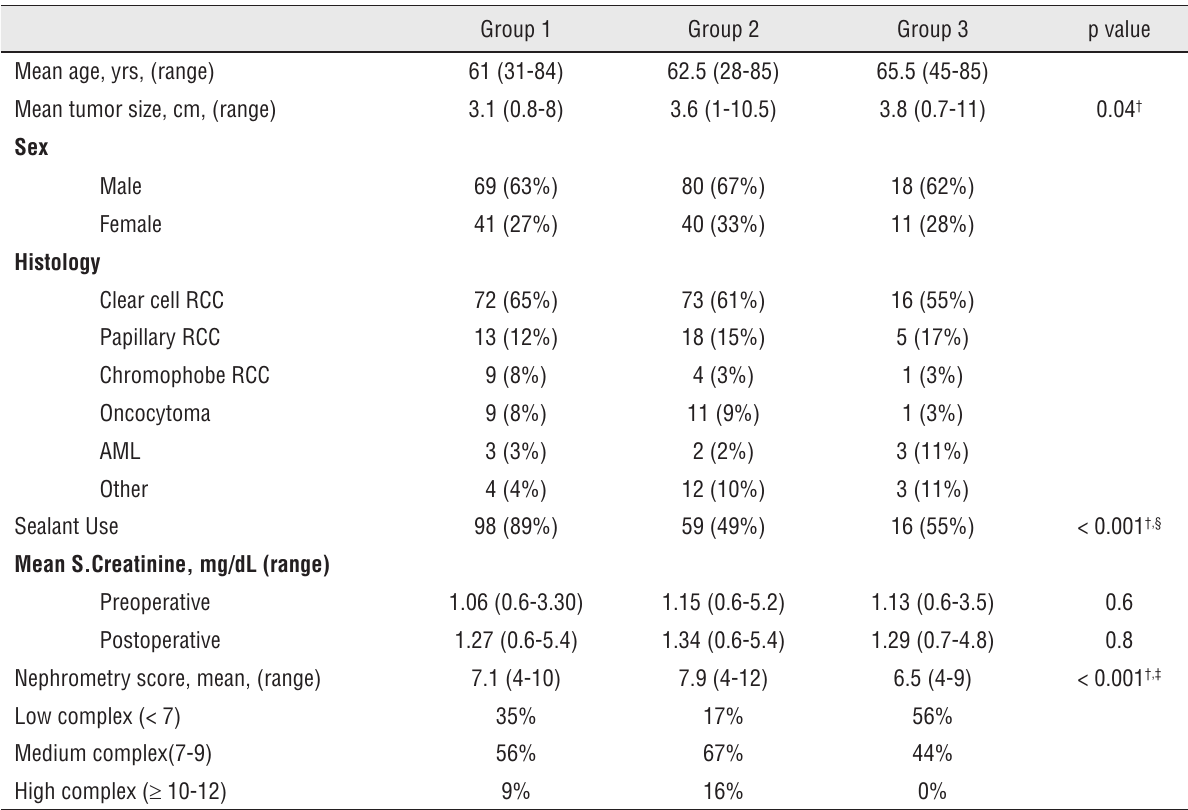
Table 1 - Patient